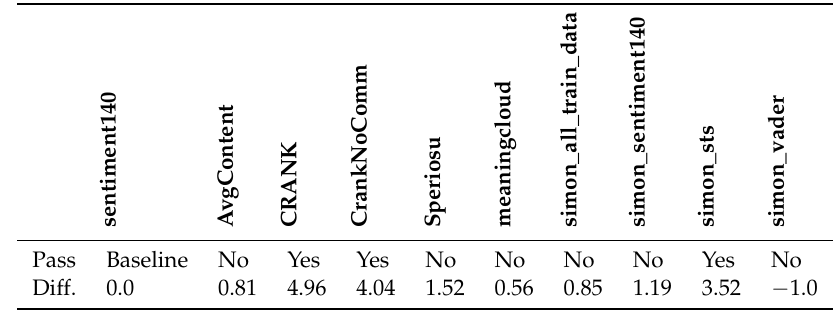
Table 5. Ranking from Friedman’s test in content-level